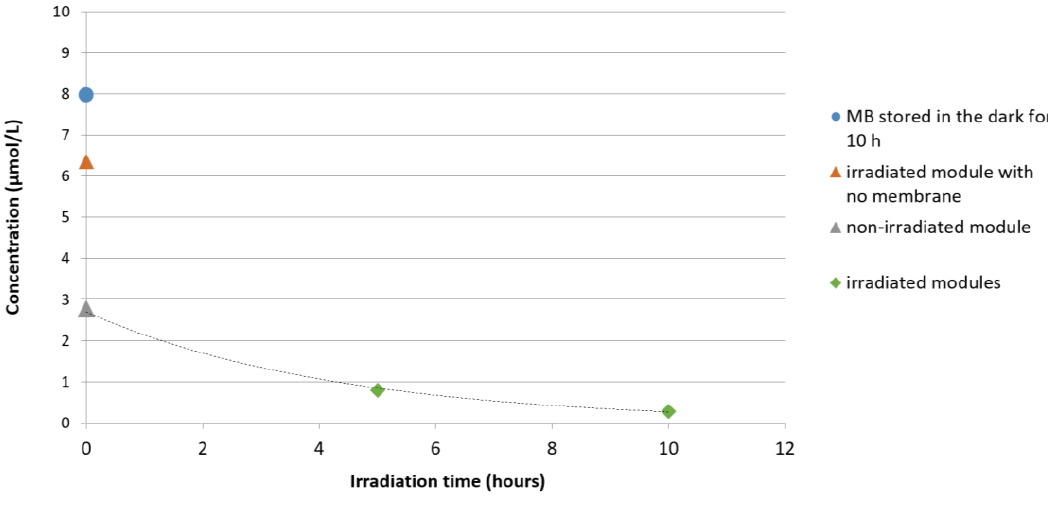
Figure 8. Qualitative concentration change of the aqueous methylene blue (MB) solution: Blue circle: MB solution stored in the dark for 10 h; orange triangle: irradiated module filled with MB solution but not containing any fiber; grey triangle: non-irradiated module containing PES+TiO 2 hollow fibers (HF); green diamond: irradiated module containing PES+TiO 2 HF.